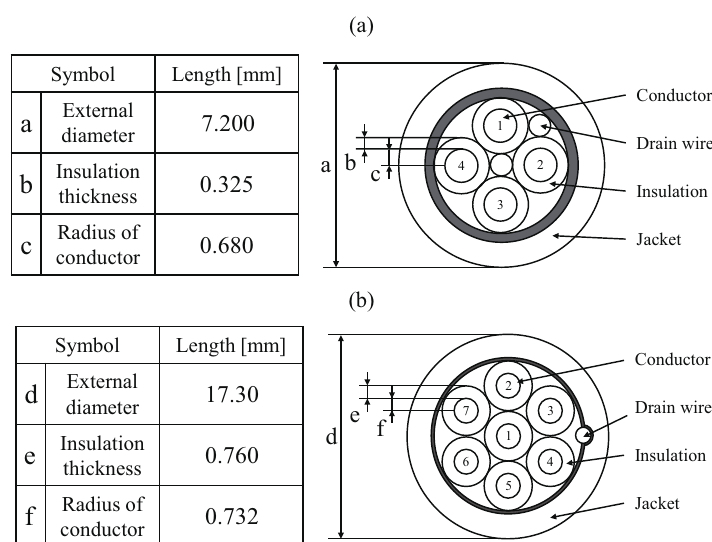
Figure 5. C&I cable cross section. ( a ) four-core C&I cable and ( b ) seven-core C&I